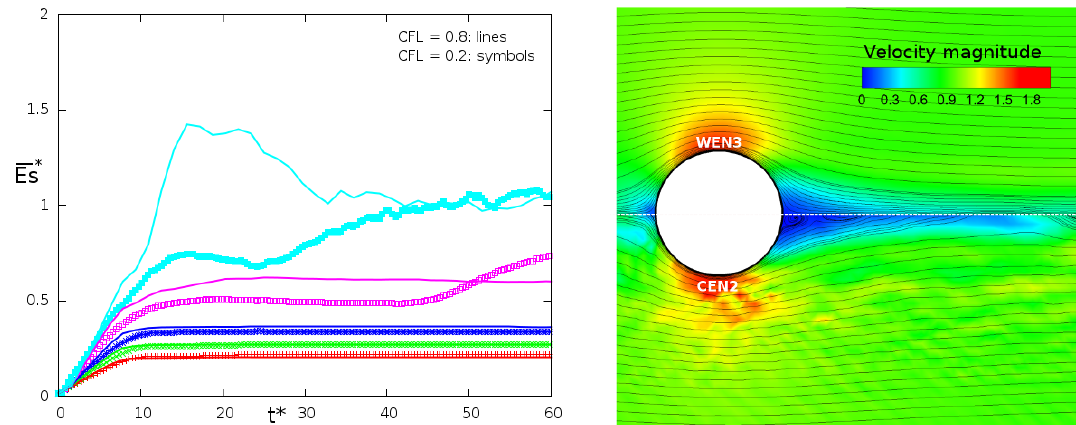
∗ ∗ ) influenced by the Courant number (CFL = 0.8, line; CFL = 0.2, Figure B1. Solving the Euler equations: (a) vorticity production E s (t symbol) and by the ν art artificial viscosity (red, green, blue, purple and cyan, respectively; ν art = ν ref art [ 1 ; 2 ; 4 ; 16 ; 256 ] − 1 ) using an advection CEN2 second-order centered scheme near the interface; (b) velocity magnitude field obtained with a WEN3 third-order weighted essentially non-oscillatory scheme (top) and CEN2 + ν ref art 256 − 1 (bottom). CEN4 is the advection scheme used far from the interface. The mesh is the coarser one (MESH1).